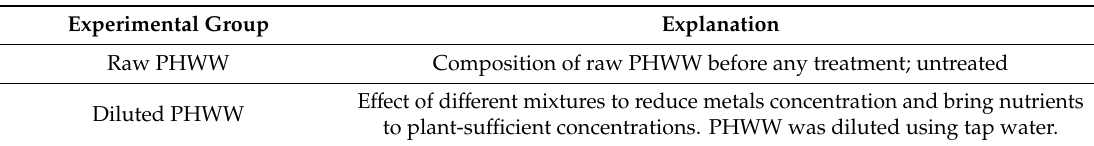
Table 1. Explanation of experimental groups for Post-Hydrothermal Liquefaction Wastewater (PHWW)